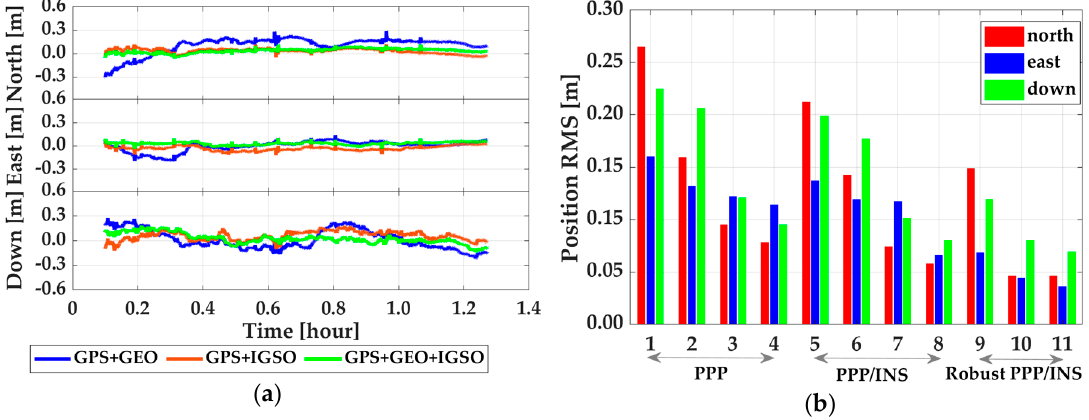
Figure 7 . Position offsets of robust PPP/INS tight integration ( a ) and position RMS of all data processing modes ( b ); in subfigure ( b ), 1–4 denote PPP using GPS, GPS + GEO, GPS + IGSO, and GPS + GEO + IGSO, 5–8 denote PPP/INS tight integration using GPS, GPS + GEO, GPS + IGSO, and GPS + GEO + IGSO, 9–10 denote robust PPP/INS tight integration using GPS + GEO, GPS + IGSO, and GPS + GEO + IGSO. Table 2. RMS of position offsets of PPP, PPP/INS tight integration (PPP/INS), and robust PPP/INS tight integration (robust PPP/INS) by comparing with GPS + BDS RTK/INS tight integration solutions (unit: m).